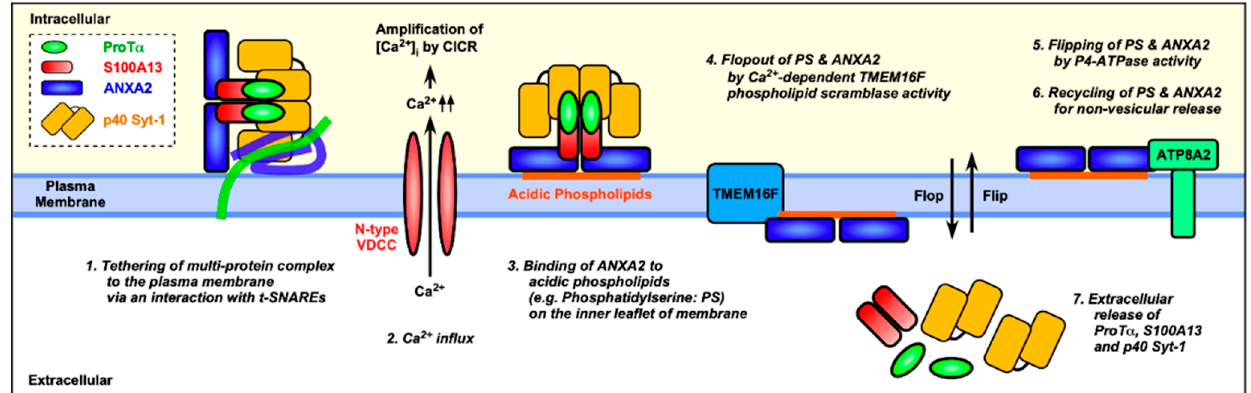
Figure 6. Schematic illustration for the mechanism of stress-induced non-vesicular release of ProT α and S100A13. A multi- protein complex consisting of ProT α (green), S100A13 (red), p40 Syt-1 (yellow) and ANXA2 (blue) is Ca 2+ -dependently assembled. This complex is tethered to the plasma membrane via an interaction between p40 Syt-1 and t-soluble N- ethylmaleimide-sensitive factor-attachment protein receptors (SNAREs), and then binds to the cytoplasmic leaflet of phos- pholipids via the Ca 2+ -dependent interaction between ANXA2 and phosphatidylserine (PS). Transmembrane protein 16F (TMEM16F), a phospholipid scramblase, causes an externalization of PS and flop-out of ANXA2 in a Ca 2+ -dependent man- ner. Recruitment of ANXA2 results in the extracellular release of ProT α , S100A13 and p40 Syt-1 in a non-vesicular route. P4-ATPase (ATP8A2 in C6 glioma cells) contributes to recycling of molecules in the non-vesicular release mechanism by flipping of PS and ANXA2.